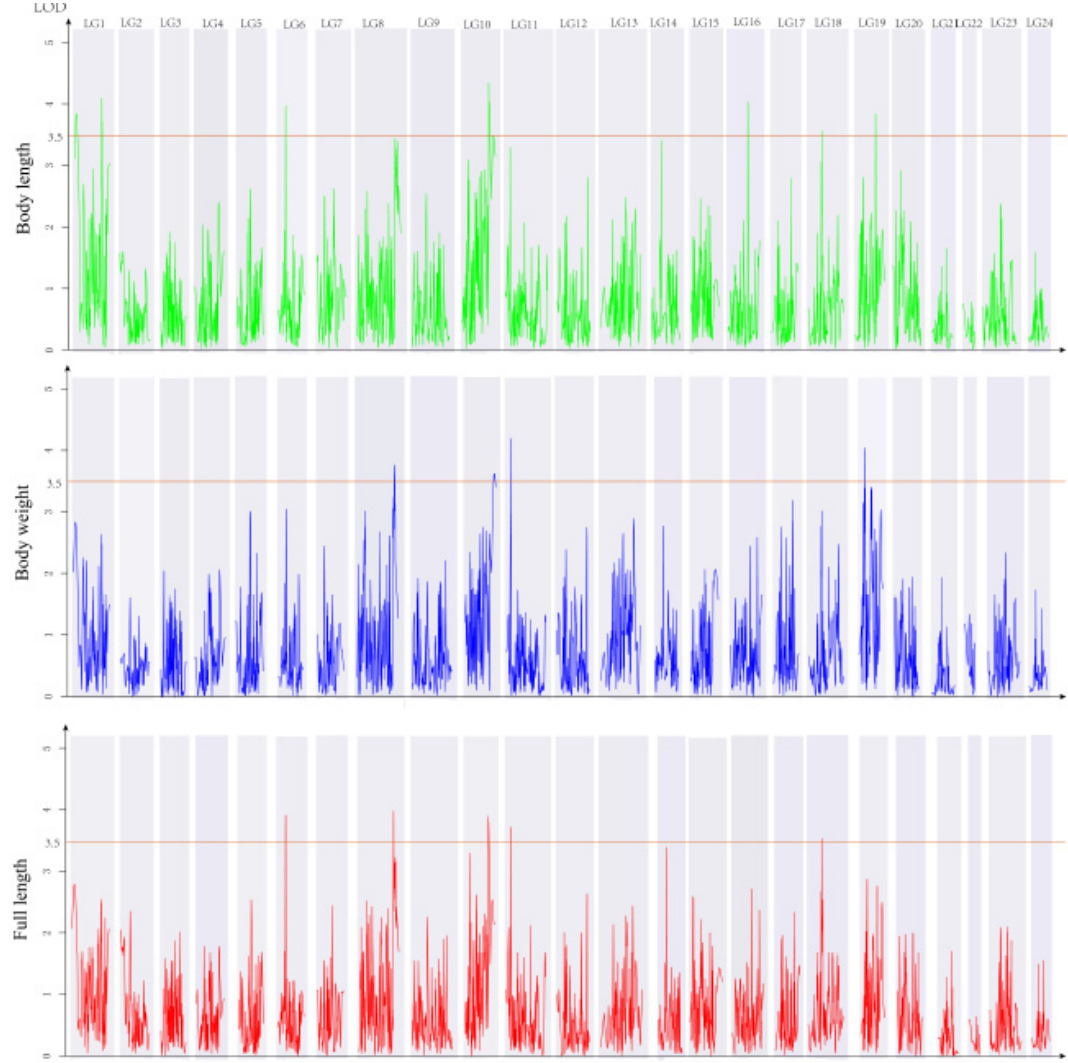
Figure 2. Genetic locations of growth-related QTLs on the 24 LGs of the red-spotted grouper. Green horizontal lines indicate the cutting threshold of LOD at 3.5. Green, blue, and red represent the body length, body weight, and full length traits, respectively.